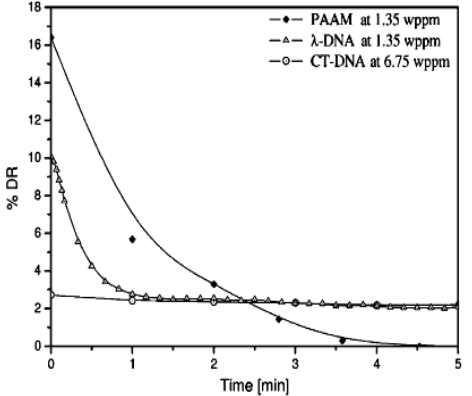
Figure 9. Comparison of the drag reducing characteristics of calf thymus DNA (CT-DNA) with those of linear high molecular weight synthetic polyacrylamide (PAAM) (polydisperse) and monodisperse λ -DNA, reprinted with permission from [83]. Copyright Elsevier, 2005.